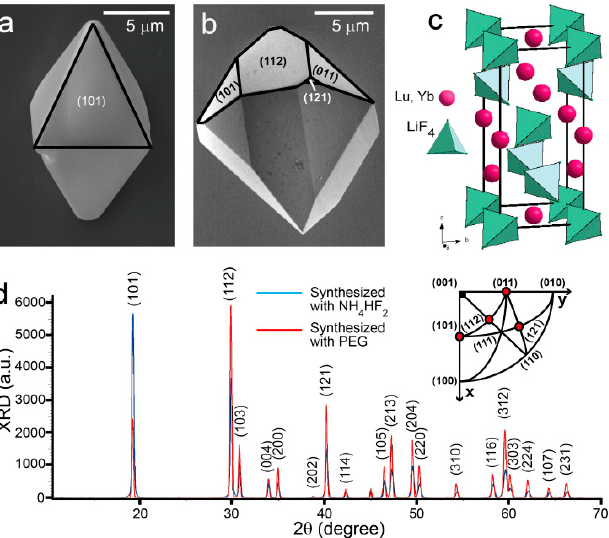
Figure 2. Characterization of Yb:LLF crystals. Scanning electron microscope images of faceted Yb:LLF particles synthesized with NH 4 HF 2 - ( a ) and PEG-assisted ( b ) hydrothermal syntheses. Scale bar = 5 μ m. Types of facets are indicated in parentheses. ( c ) Schematic of a Scheelite crystal structure of Yb:LLF with I 4 1 / a space group symmetry. ( d ) Powder XRD pattern of Yb:LLF crystals following NH 4 HF 2 - (blue) and PEG-assisted (red) hydrothermal synthesis, indicating a Scheelite crystal structure. Inset: stereographic projections of crystal facets related to the most intensive XRD peaks.